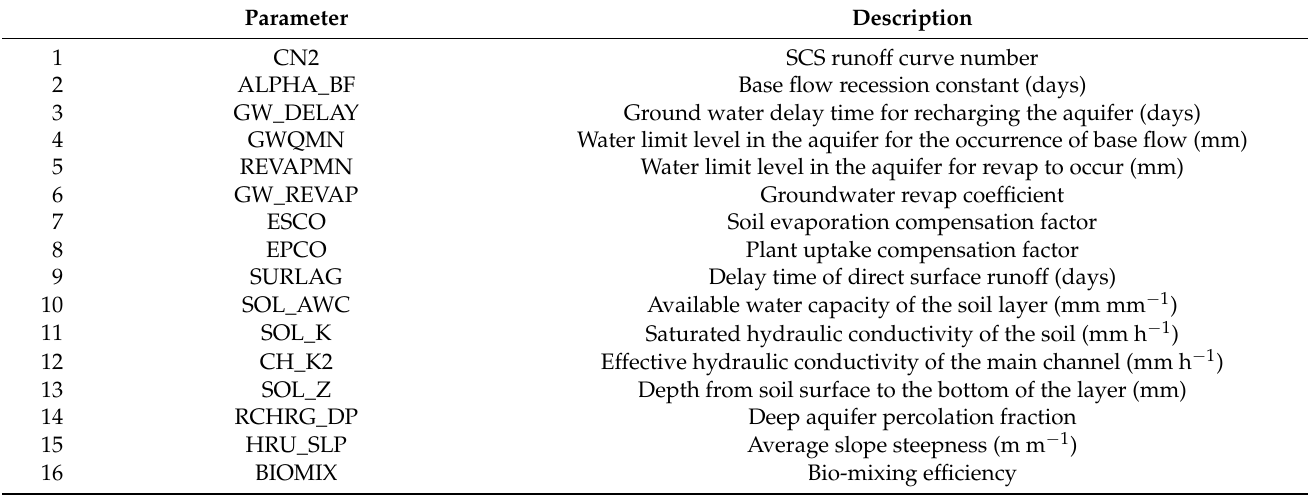
Table 3. The most sensitive SWAT parameters identified in the CRV sub-basins, and their